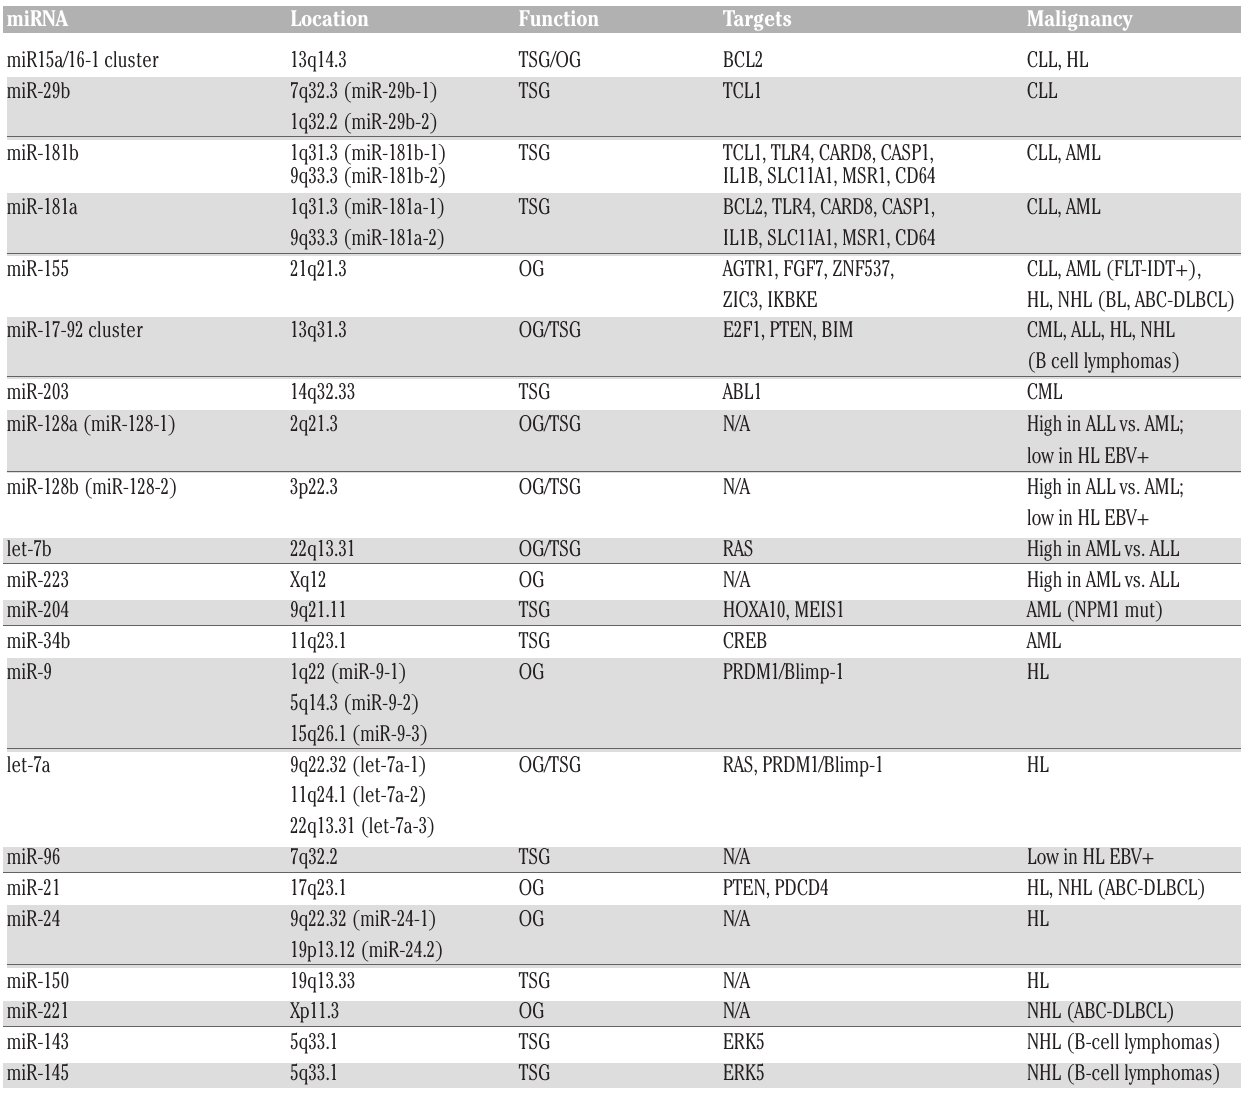
Table 1. Main aberrantly expressed miRNAs in hematologic